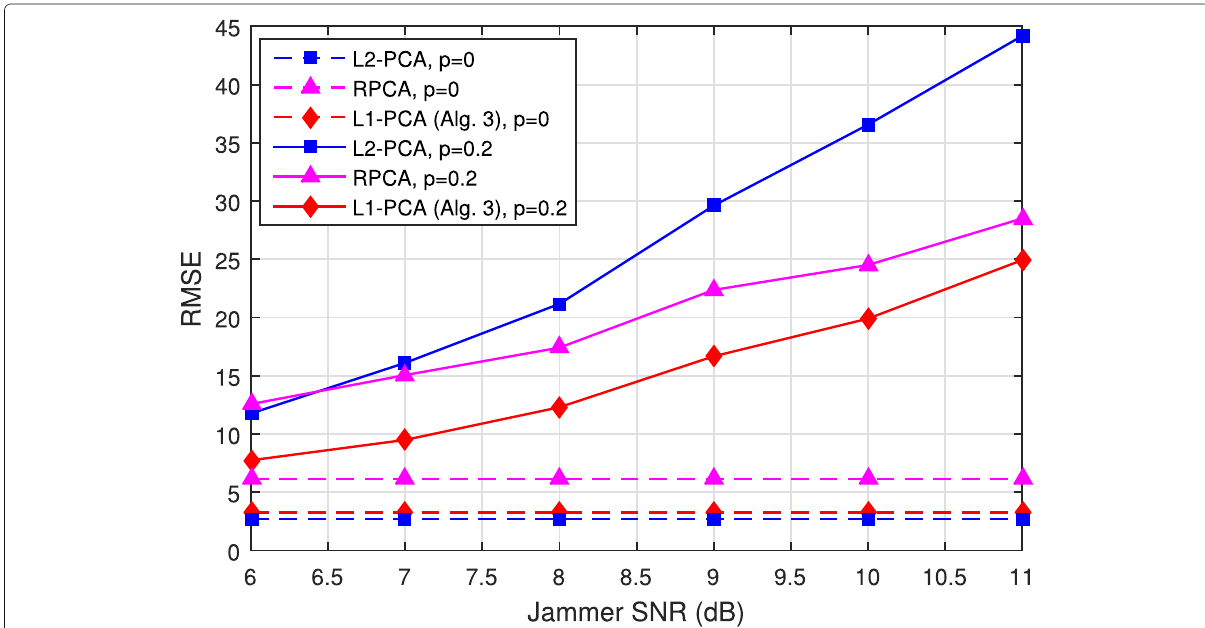
Fig. 8 RMSE vs. jammer SNR, for: L2-PCA (MUSIC), RPCA [29], and L1-PCA by means of Algorithm 3 in Fig. (4). For each estimator, we present the RMSE curves for p = 0,.2. N = 10, D = 4, θ = − 20 ◦ , θ (cid:13) = 50 ◦ , source SNR 5